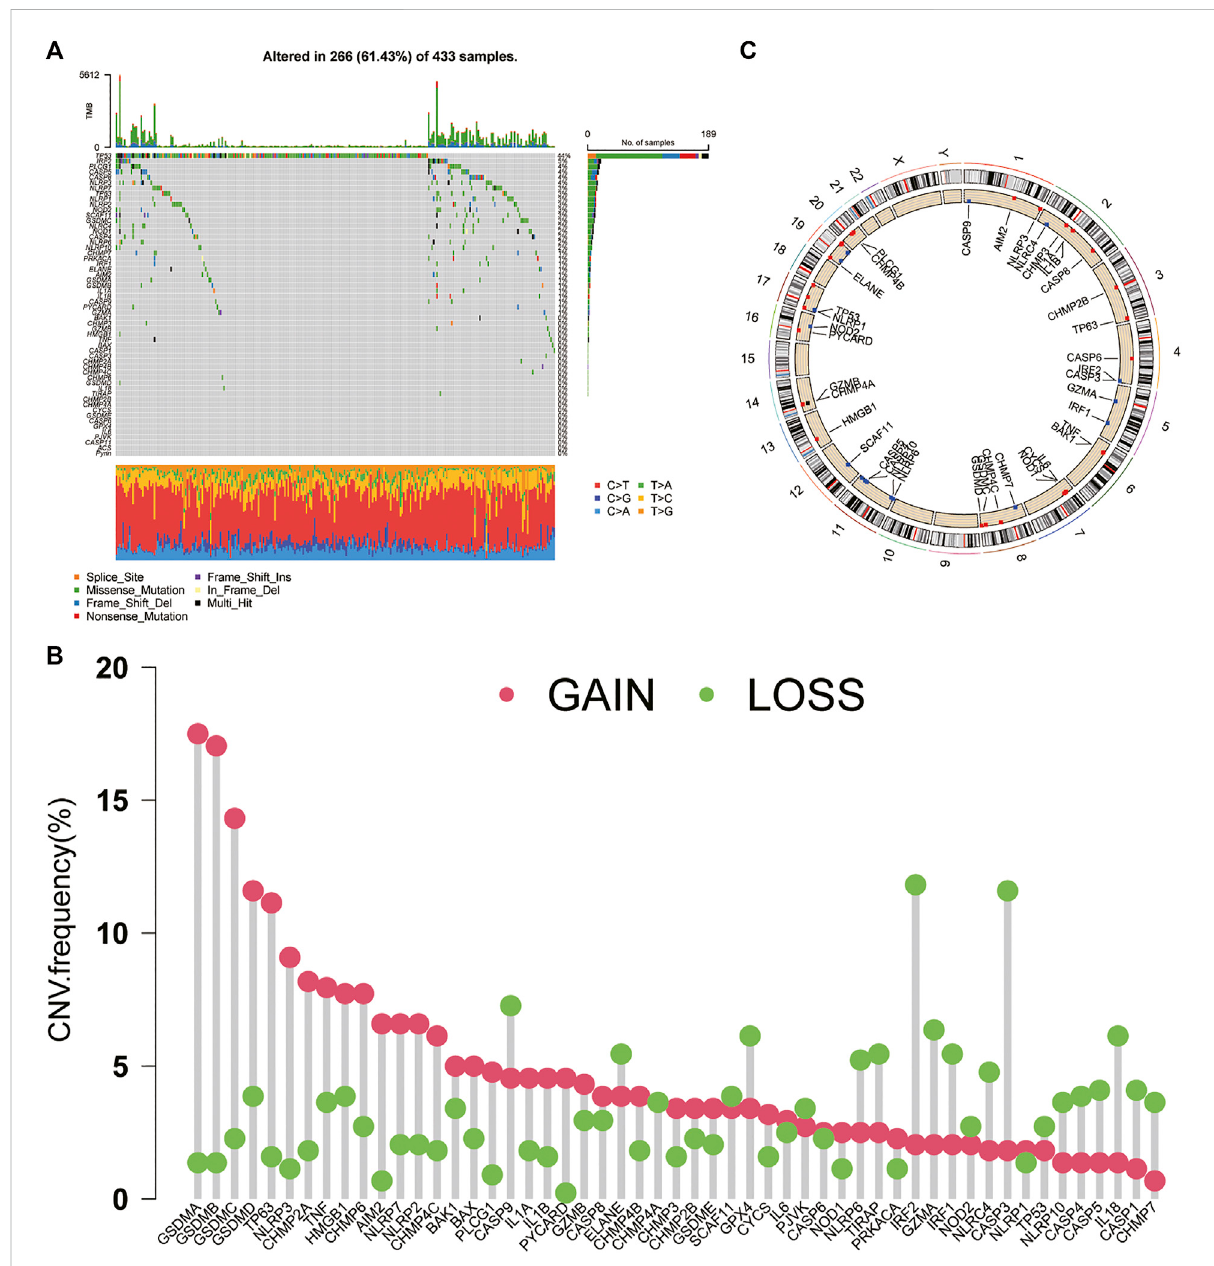
unsupervised cluster analysis of PRGs (Supplementary Figure S3). The results showed that k = 2 was the best choice, with the highest sample correlation within the A and B subtypes (Figure 2C). In addition, PCA also con fi rmed this result; that is, GC samples can be divided into two subtypes, A and B, according to the expression levels of PRGs (Figure